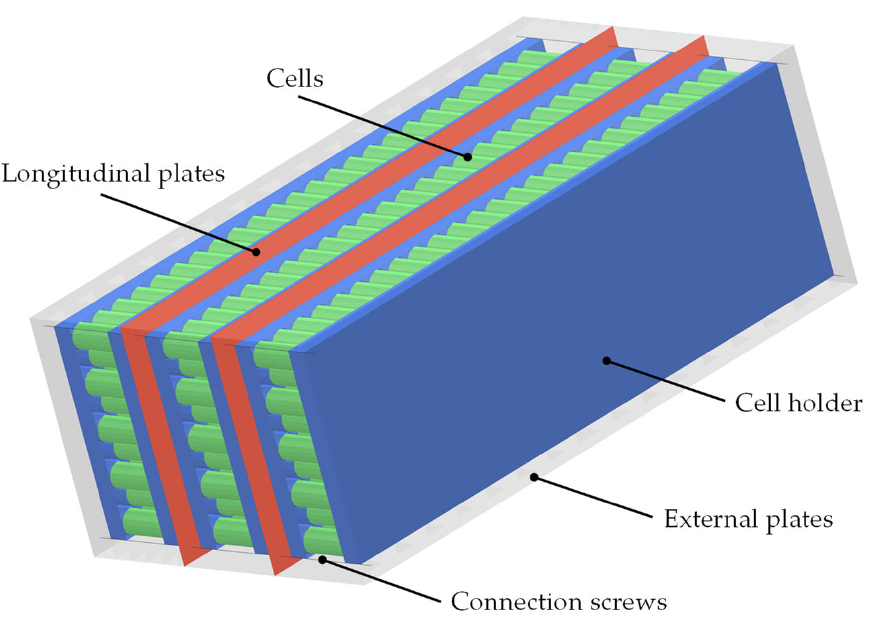
Figure 3. Schematic sketch of the traction battery of Concept Y with its components. The external plates are semi-transparent to show the inner components of the traction battery [33].